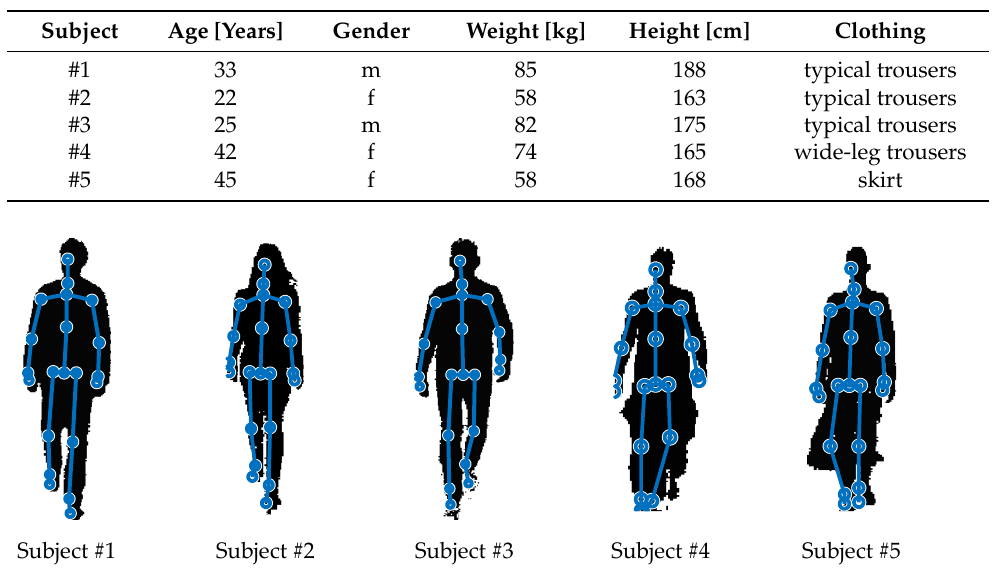
Figure 6. Examples of the results of detecting the silhouettes and locating the anatomical landmarks of the 5 people participating the experiment.